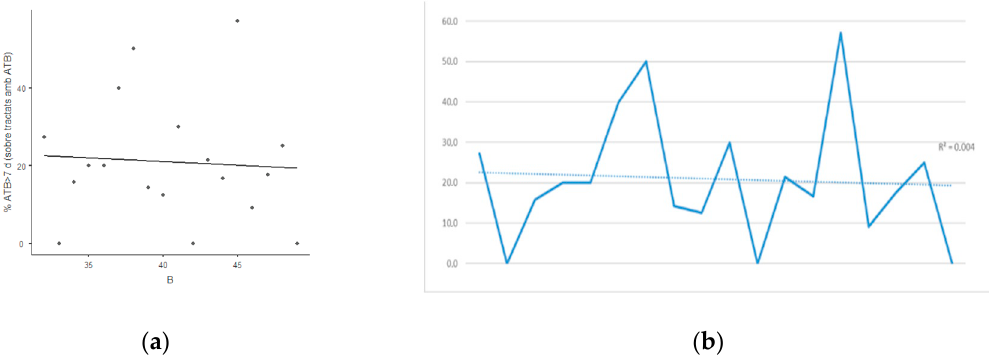
Figure 3. Evolution of the percentage of antibiotic treatments >7 days over patients treated with antibiotics in the Department of Surgery the second 8 month-period, containing the COVID-19 pandemic (IP2). ( a ) Scatterplot (rho = − 0.103); ( b ) Temporal evolution of the percentage of patients on antibiotic treatment with a duration of over 7 days (R 2 = 0.004).